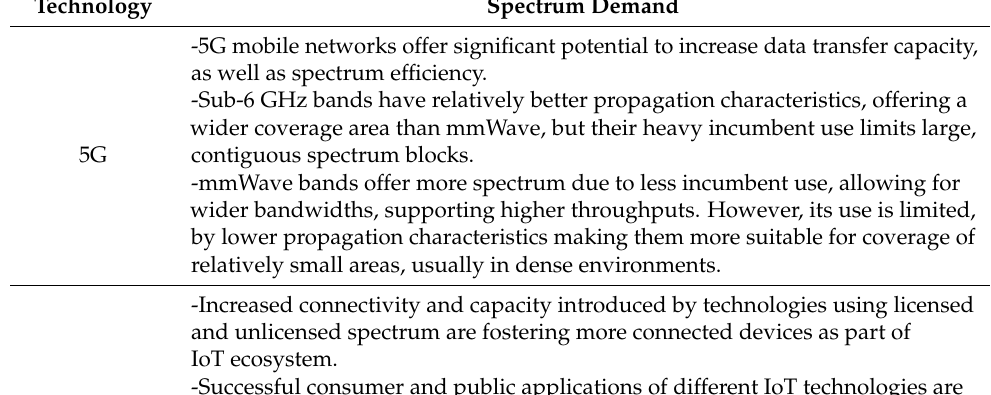
Table 1. Technologies driving spectrum